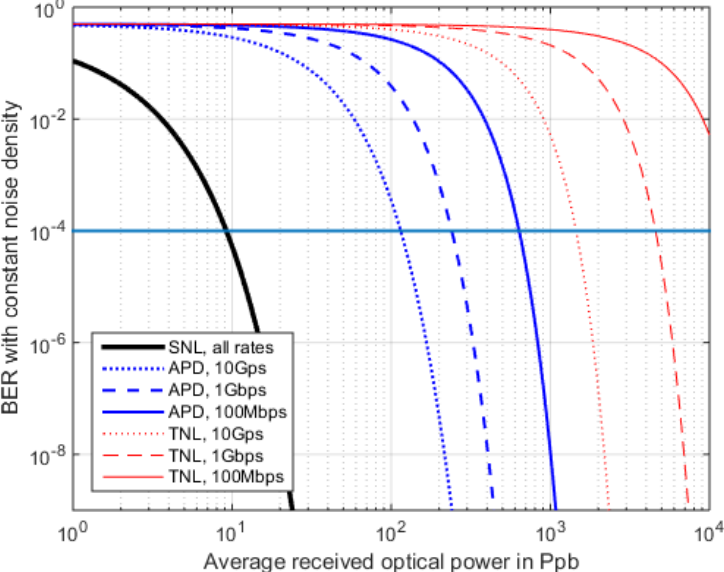
Figure 9. BER from <N> , with a constant TIA noise density and adaption of receiver filter only. Same parametrization as Figure 8.